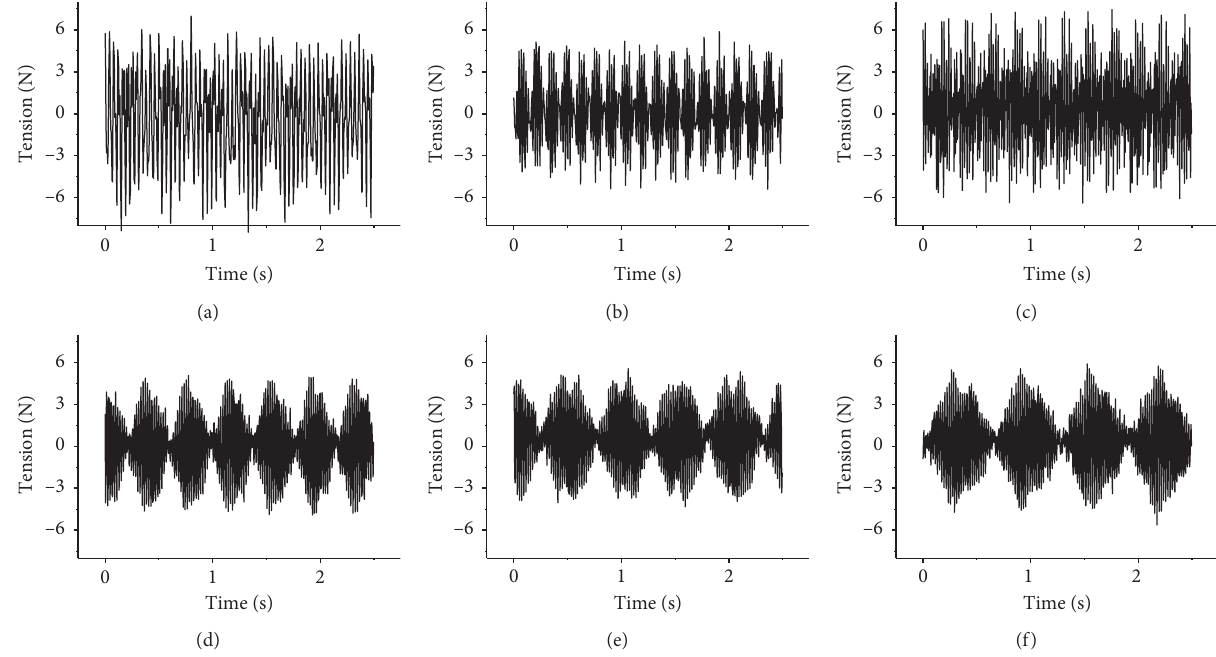
Figure 6: Tension test signal for the static rope under different excitation grades.